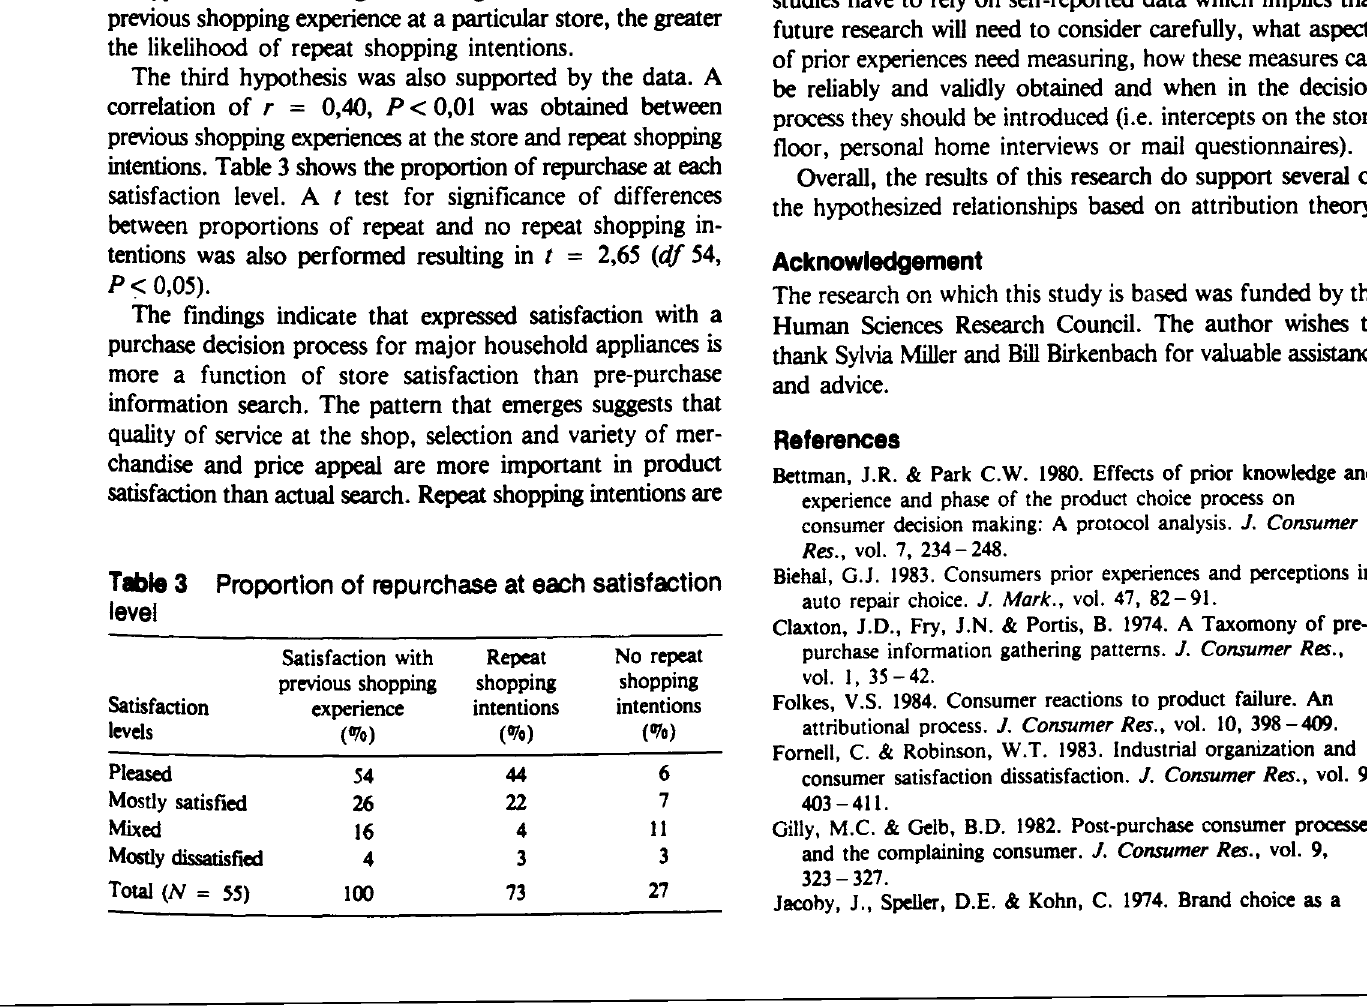
Percentage of responses at each